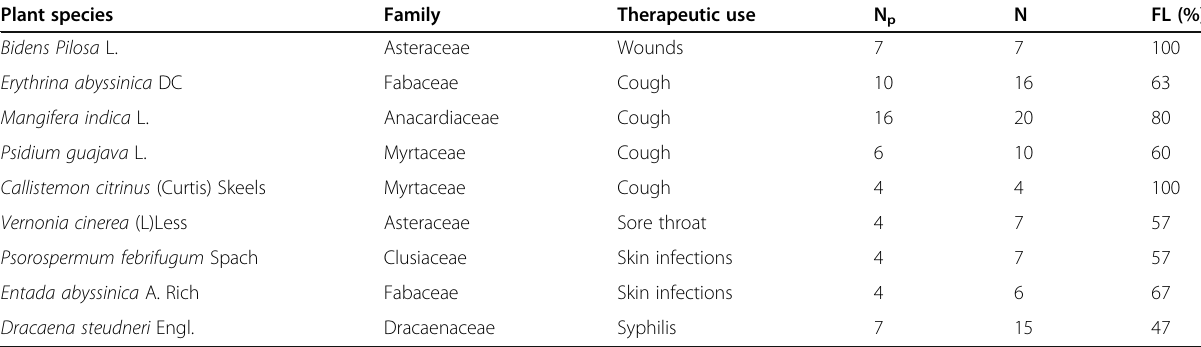
Table 4 Fidelity levels of the frequently reported plants and their major uses Plant